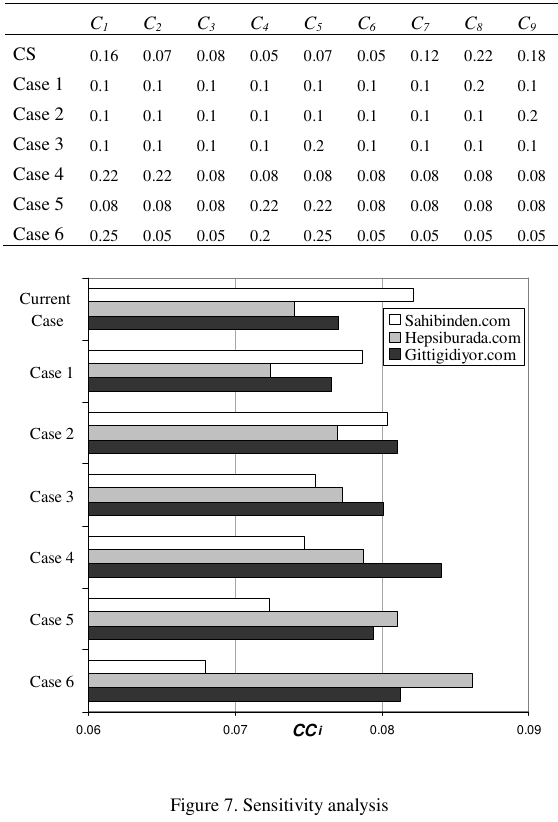
Table 11: Criteria weights with respect to the considered cases